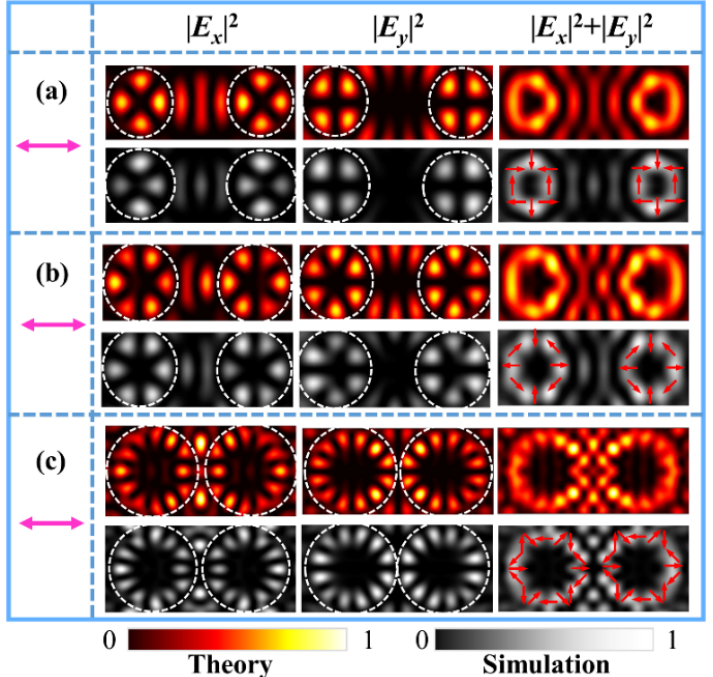
Figure 5. ( a – c ) The theoretical and FDTD simulated results of the x -, y -component, and the total intensities of the FVBs produced by metasurfaces with parameters ( q l , φ l 0 ; q r , φ r 0 ) = (1, 0°; 1, 0°), (1.5, 0°; 1.5, 0°), and (3, 0°; 3, 0°), respectively, under illumination of horizontally polarized light. The purple double arrows indicate the polarization direction of the incident light, and the arrows on the intensity doughnuts represent the schematic polarization distributions.